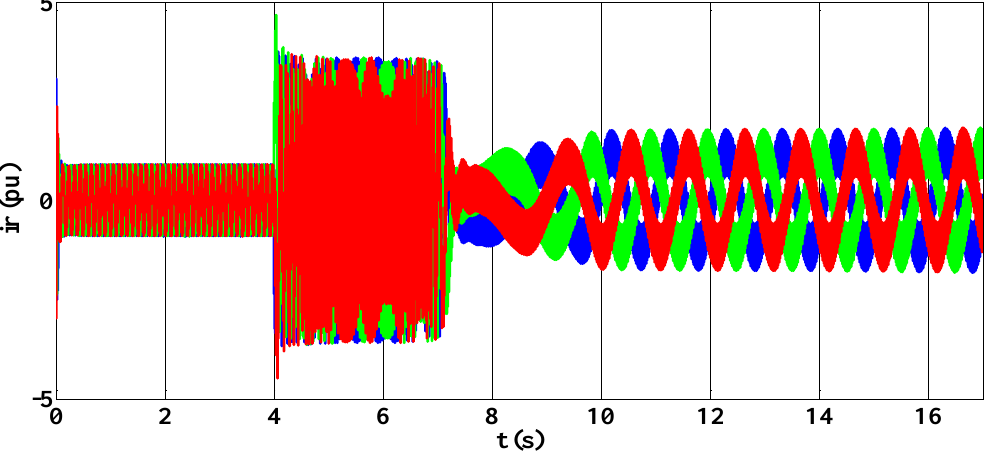
Figure 19. Rotor currents (short-circuit happens at t = 4